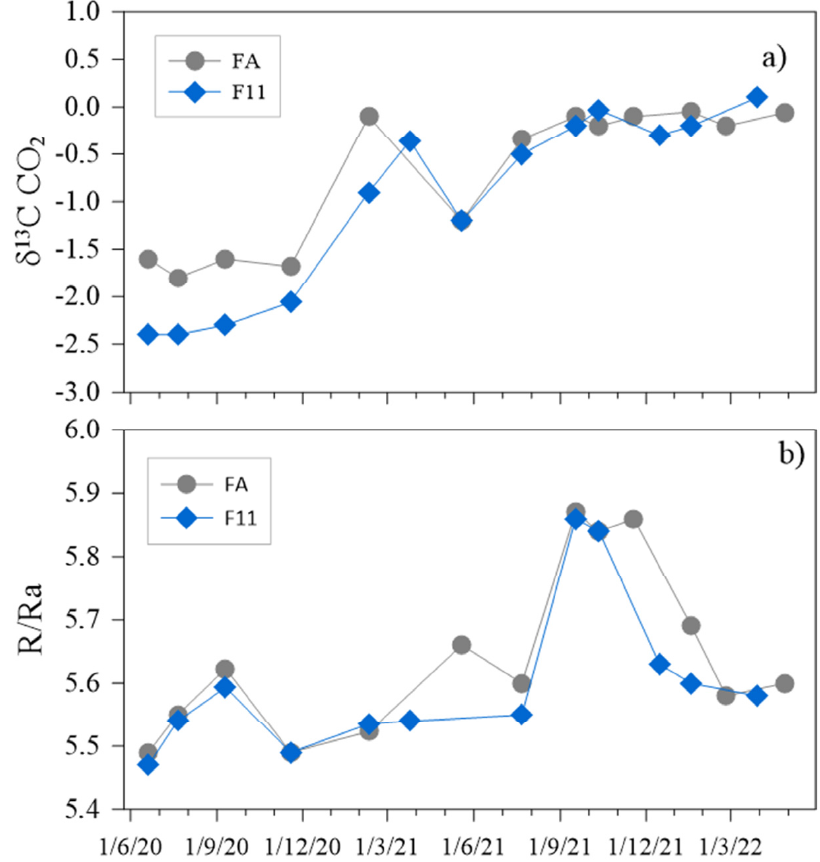
Figure 5. Time trends of ( a ) carbon isotope composition of CO 2 in the gas of fumaroles FA and F11 and ( b ) R/Ra values of He.